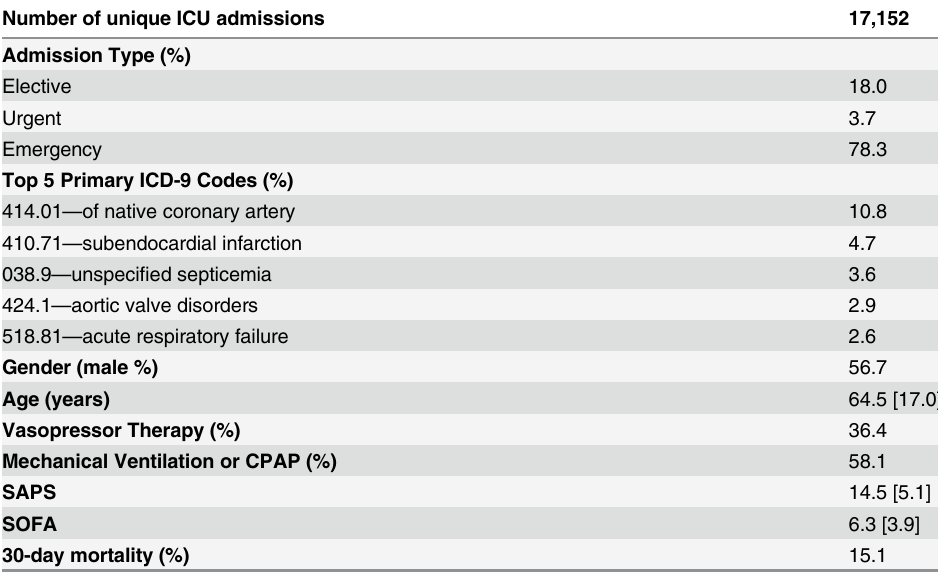
Table 1. Patient data